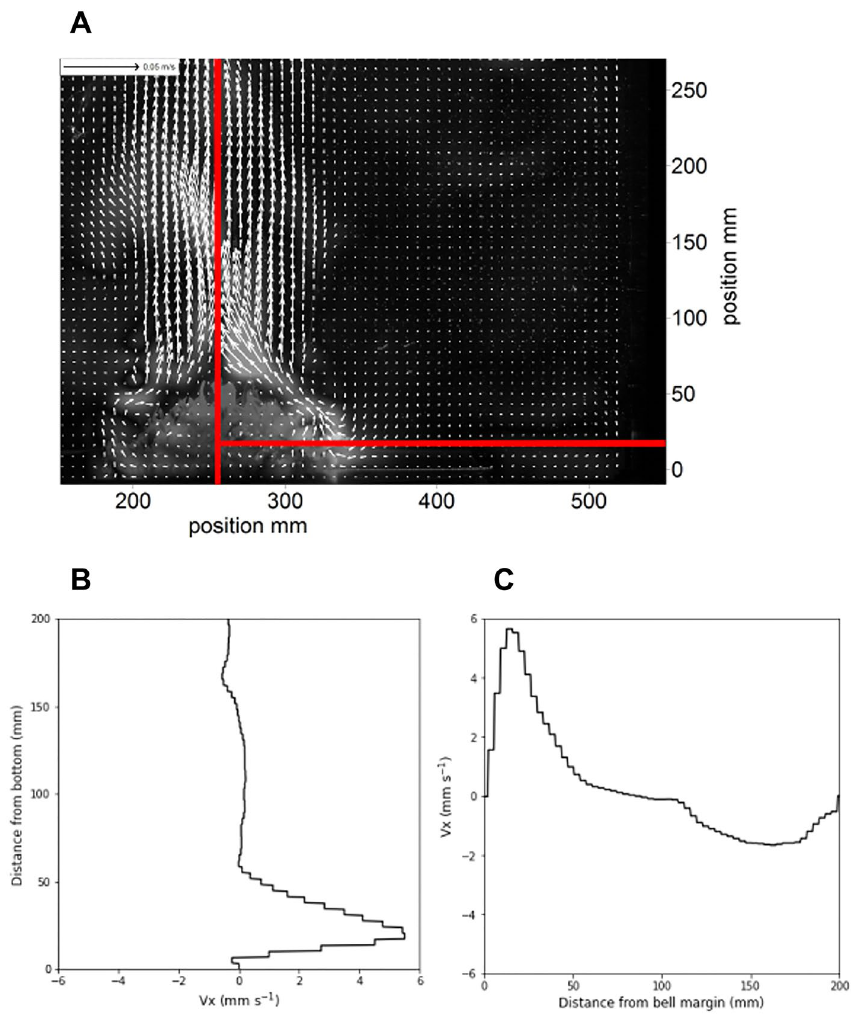
Figure 4. Flow components. The feeding current of Cassiopea sp. imaged via Particle Image Velocimetry. ( A ) The shape of the flow shows the slow incurrent flow near the benthos and the more rapid excurrent vertical flow. ( B ) A vertical profile 1 cm to the right of the bell margin of the horizontal component of water velocity shows that a peak velocity of < 6 mm s −1 occurs 2.5 cm above the bottom. ( C ) A horizontal profile at 2 cm above the bottom shows that increased horizontal flow is limited to a narrow region near the bell margin, with peak velocities occurring within 2 cm of the